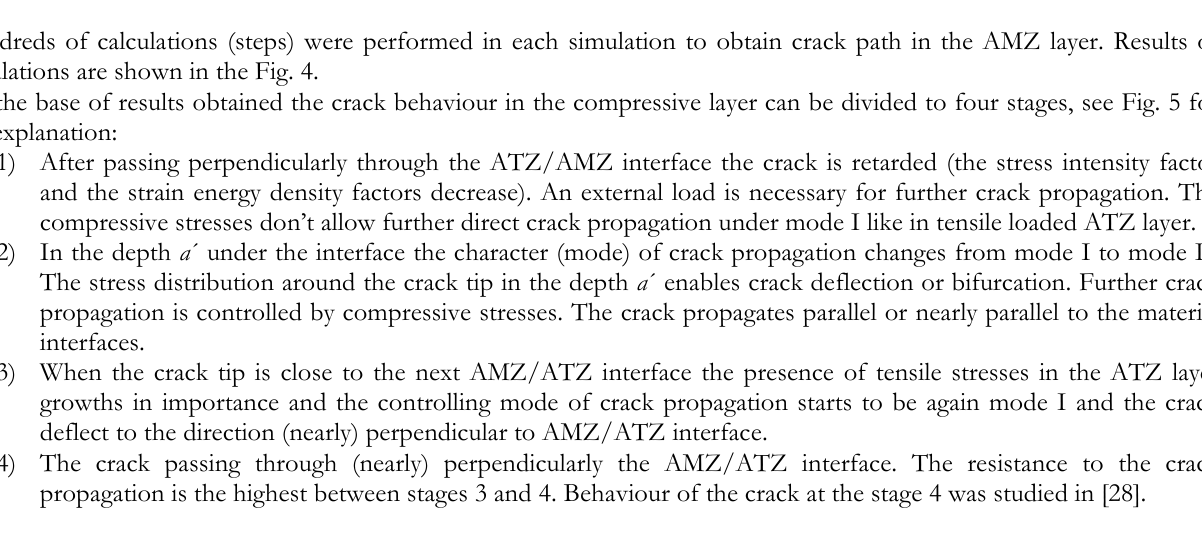
Table 3: The depth a´ in AMZ layer under the first ATZ/AMZ interface, where the crack changes mode of propagation and values of the force P acting in the moment of crack